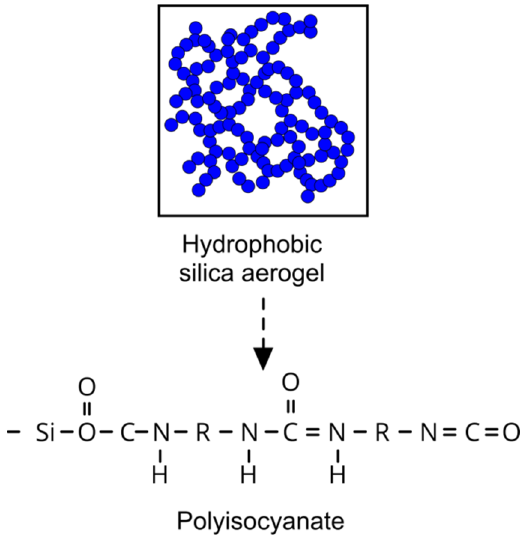
Figure 7. Reaction for amine modified aerogel crosslinking with diisocyanates [21].